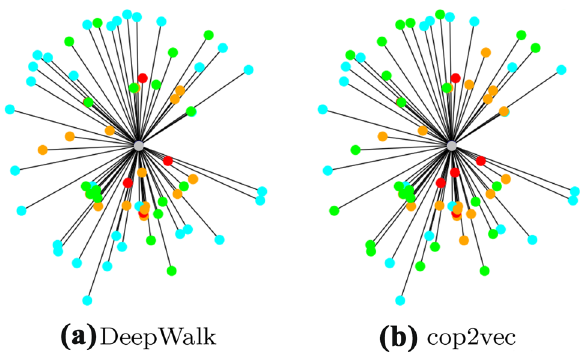
Fig. 5 The number of times co-occurrence of co-purchaser in one co- purchase on the TaoBao ( : initiator, : co-occurrence > 50 occurrence > , : co-occurrence >